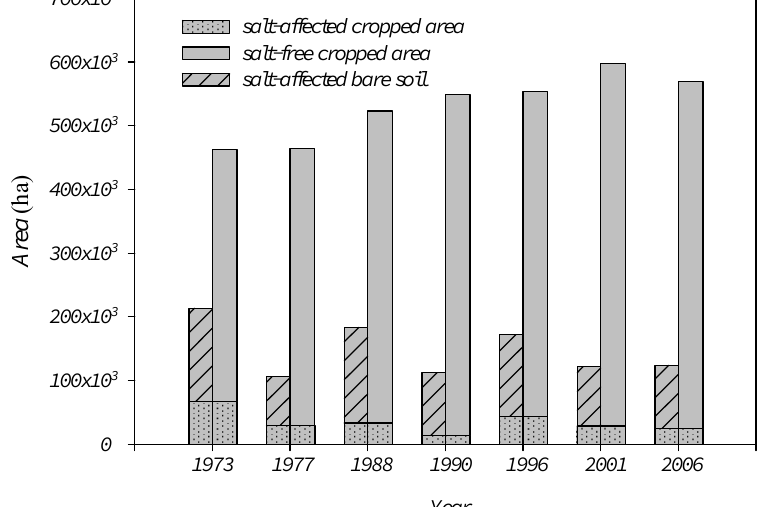
Figure 7. Salt-affected area, bare soil and salt-free cropped area in